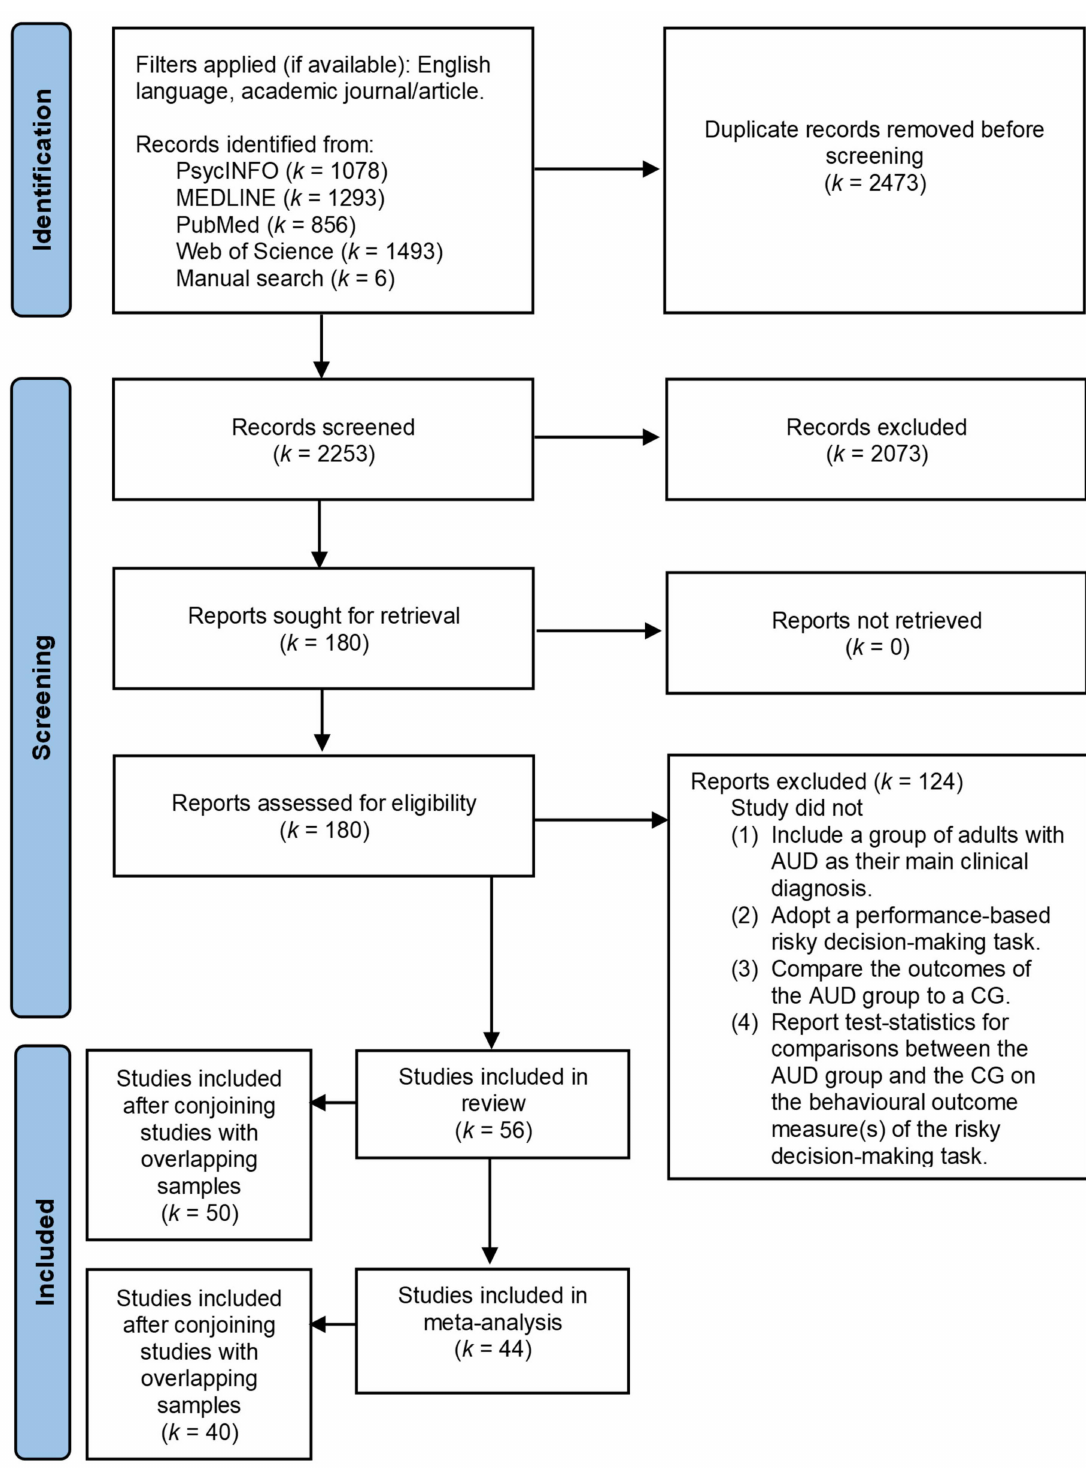
Figure 1. Flow diagram of the systematic search and review process according to the guidelines of Preferred Reporting Items for Systematic Reviews and Meta-Analyses (PRISMA 2020;